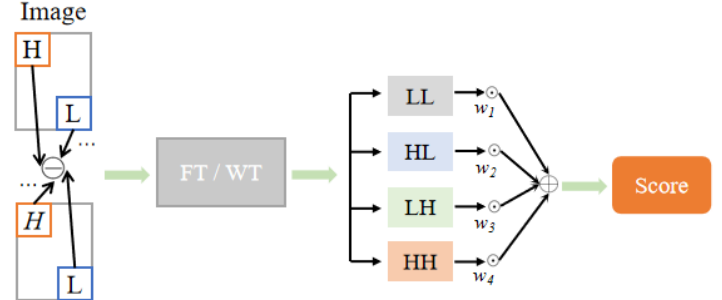
Figure 4. The general framework of spectral domain ‐ based methods .